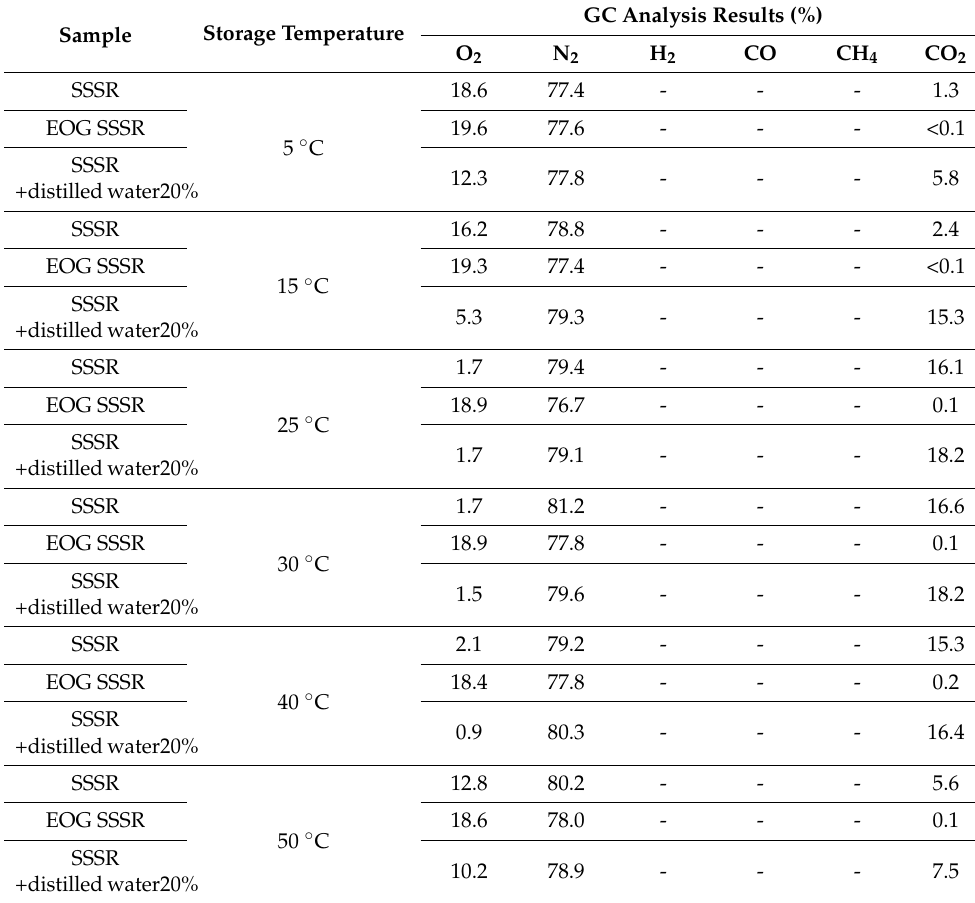
Table 8. GC data for SSSR stored at various temperatures (5–50 ◦